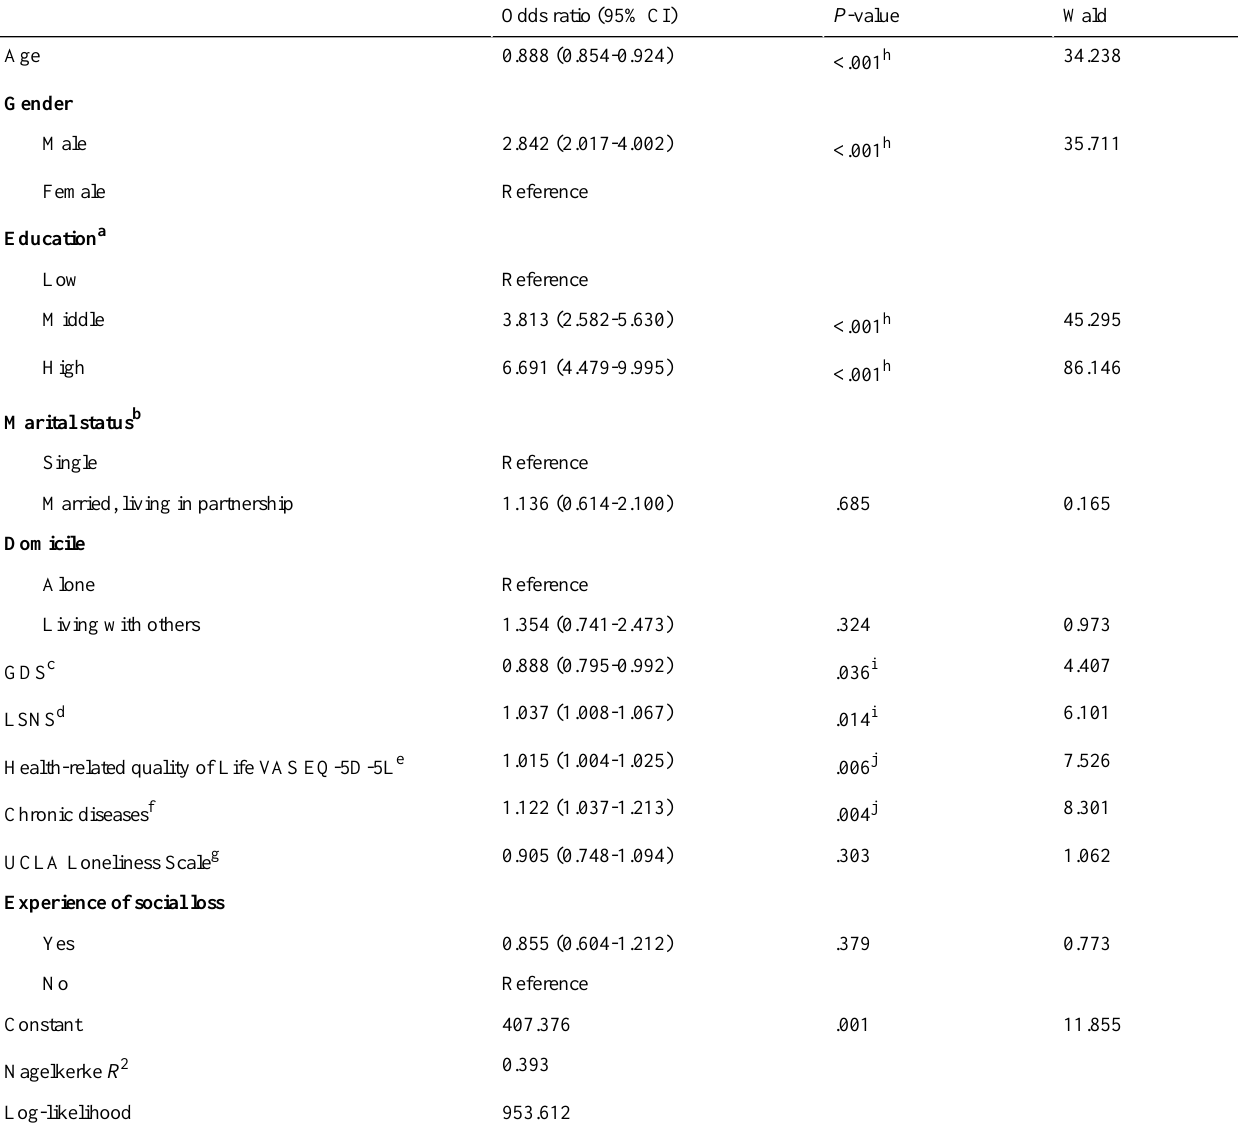
Table 3. Results of binary logistic regression analysis for variables predicting internet use versus nonuse in older adults